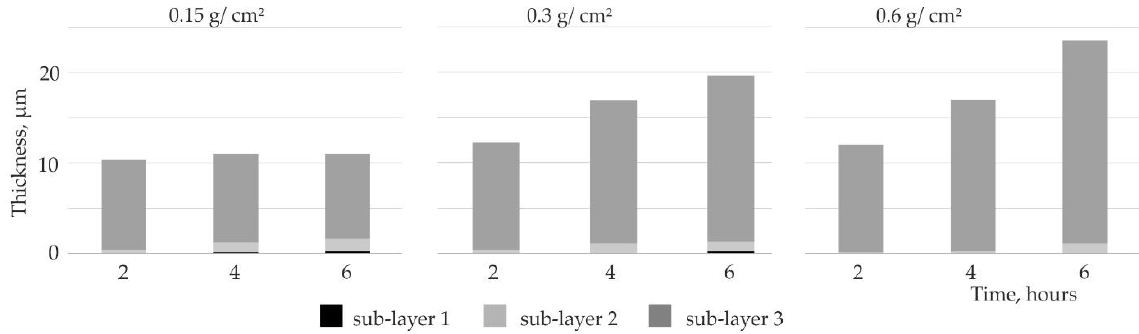
Figure 10. Thickness of Si coatings obtained at 1000 °C for different slurry volume and after varied annealing times.